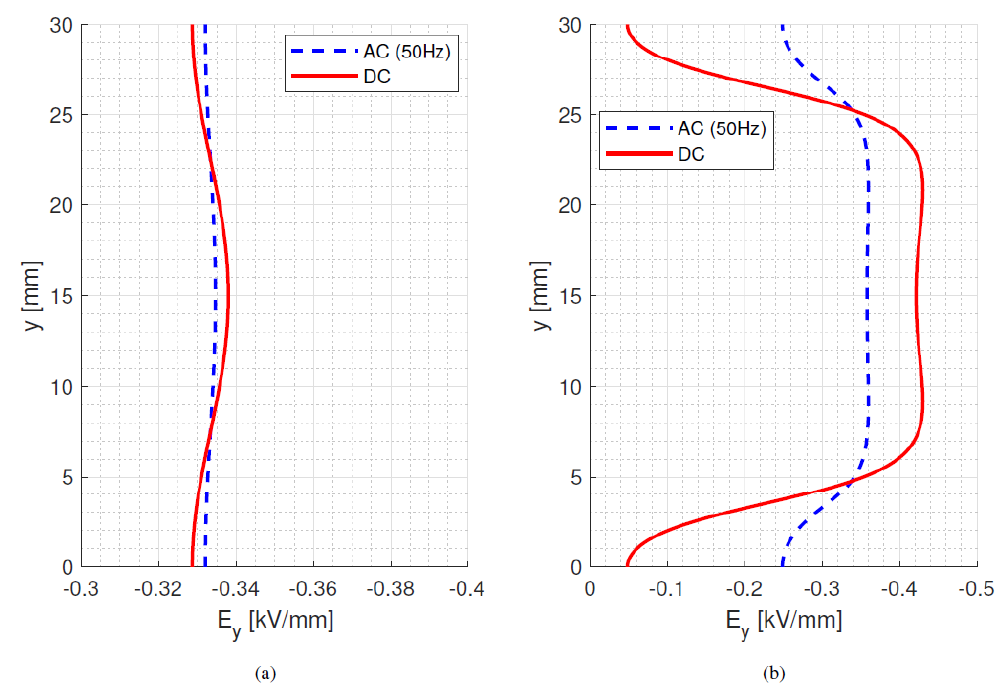
Figure 1. Bulk ( a ) and surface ( b ) ac and dc steady-state field for 10 kV at 25 °C. Model parameter values from Table 1.